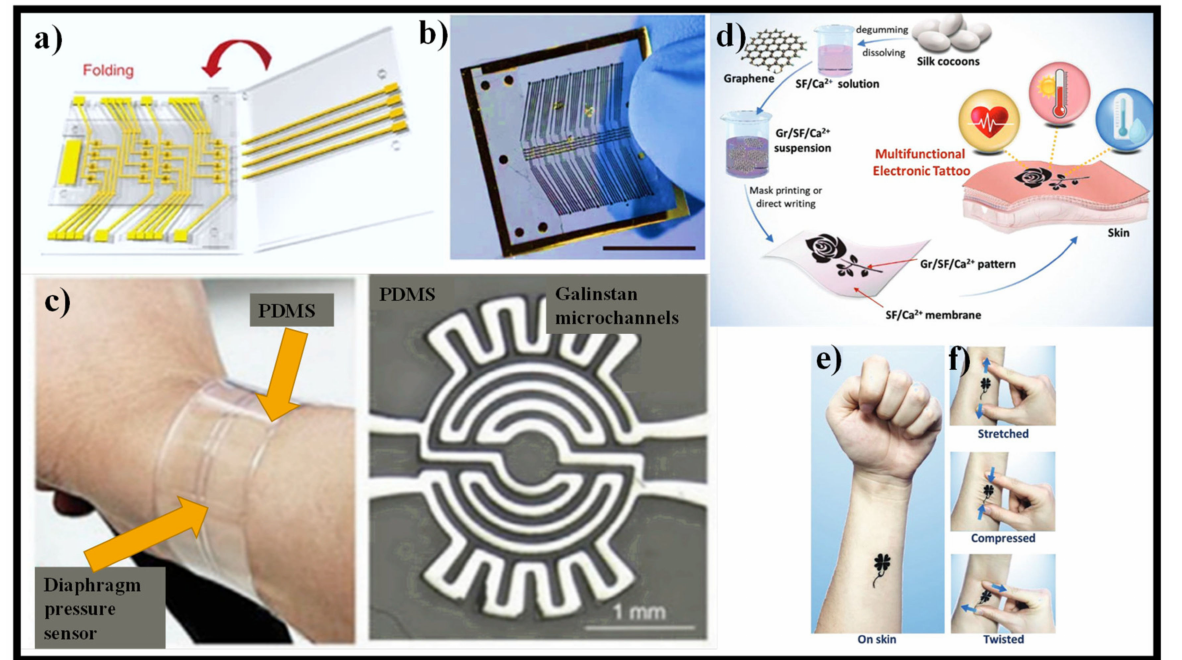
Figure 3. ( a ) Schematic image of pressure-sensitive graphene FETs with air–dielectric layers [28]. ( b ) Photograph of the manufactured pressure-sensitive graphene FETs, Scale bar, 1 cm [28]. ( c ) Mi- crofluidic elastomers [42]. ( d ) Manufacturing process of the Gr/SF/Ca 2+ E-tattoo and its stable adhesion on human skin [43]. ( e ) Photographs showing a four-leaf clover E-tattoo attached to the forearm [43]. ( f ) Photographs of the tattoo on skin in different states: stretched ( top ), compressed ( middle ), and twisted ( bottom )